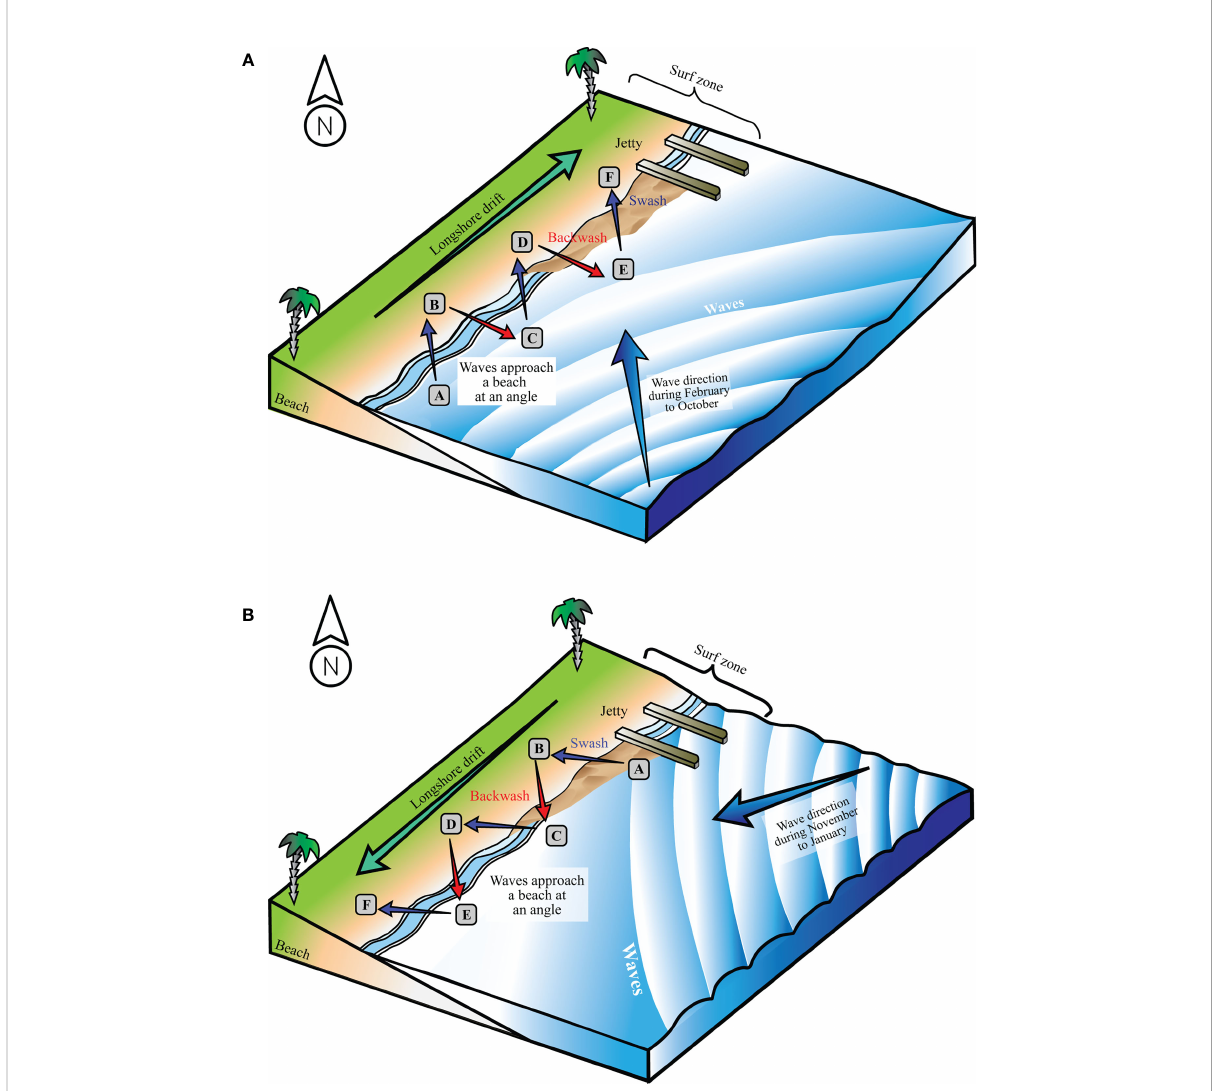
FIGURE 10 Interactions of a jetty, waves, currents, and beach morphology (A) during the southwest monsoon, waves transport sediment from A to F (northwards), creating accretion at the updrift jetty, (B) during the northeast monsoon, the waves carry the sediment away from the jetty from A to F